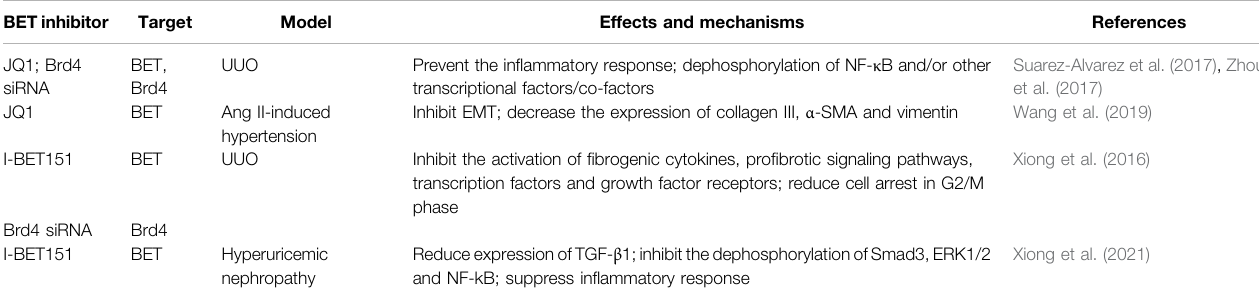
TABLE 3 | Effects of BET inhibitors on renal fi